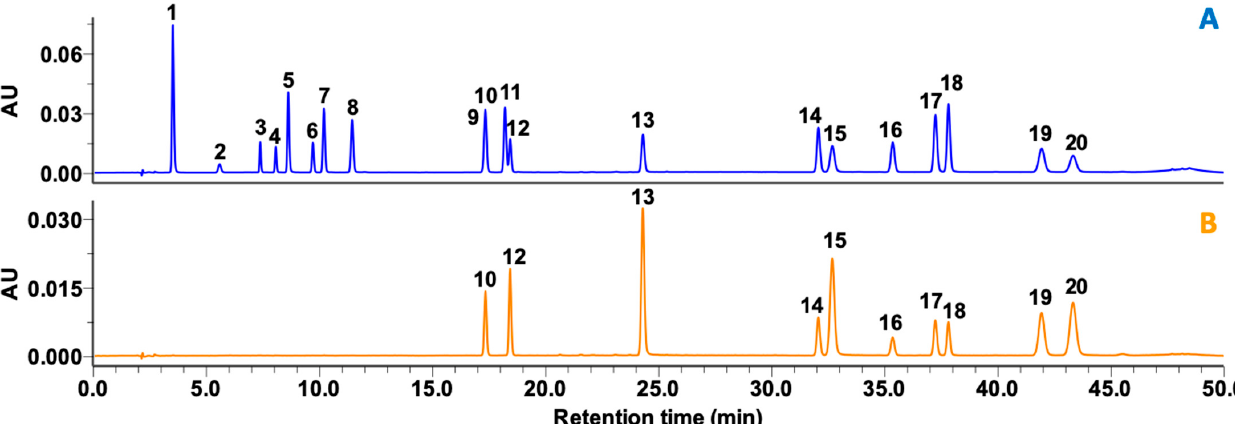
Figure 2. HPLC traces at wavelengths of ( A ) 275 nm and ( B ) 365 nm of 19 phenolics and caffeine standards found in green tea and processed teas. Peaks are indicated as follows: 1, gallic acid; 2, GC; 3, EGC; 4, C; 5, caffeine; 6, EC; 7, EGCG; 8, GCG; 9, ECG; 10, rutin; 11, CG; 12, isoquercitrin; 13, myricetin; 14, TF; 15, quercetin; 16, TF3G; 17, TF3 ′ G; 18, TF3,3 ′ DG; 19, apigenin; and 20, kaempferol. The concentrations of standard aliquots were as follows: 10 μ g/mL, peaks 5, 10, 12, 13, 15, 19, and 20; and 20 μ g/mL, peaks 1 − 4, 6 − 9, 14, and 16 − 18.